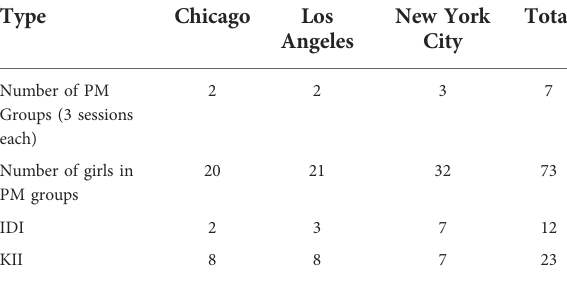
TABLE 1 Participant